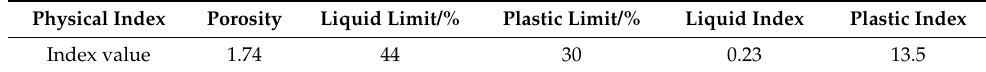
Table 1. Physical properties of soft soil in an industrial area of Shaoxing.